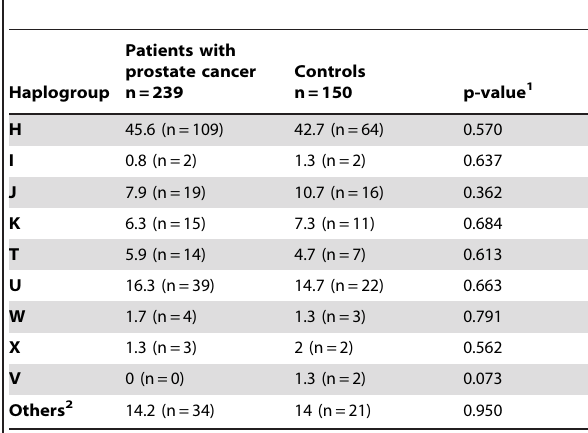
Table 2. Frequencies (%) of European mitochondrial haplogroups in cases in